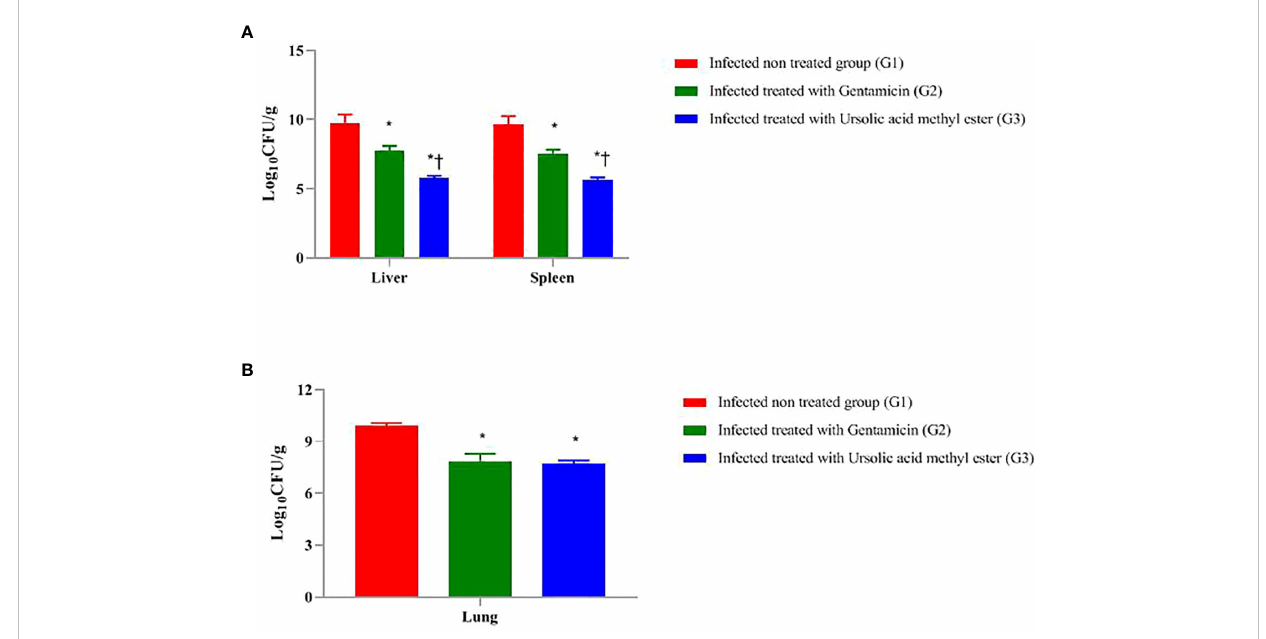
FIGURE 1 Total colony count (Log 10 CFU g -1 ) in liver and spleen of mice infected intraperitoneal with S. aureus (A) and the lungs of mice infected via the intranasal route with K . pneumoniae (B) and treated with gentamicin (10 mg/kg) and/or ursolic acid methyl ester (7.5 mg/kg). *signi fi cant difference with infected non treated group and † with gentamicin treated group ( P <